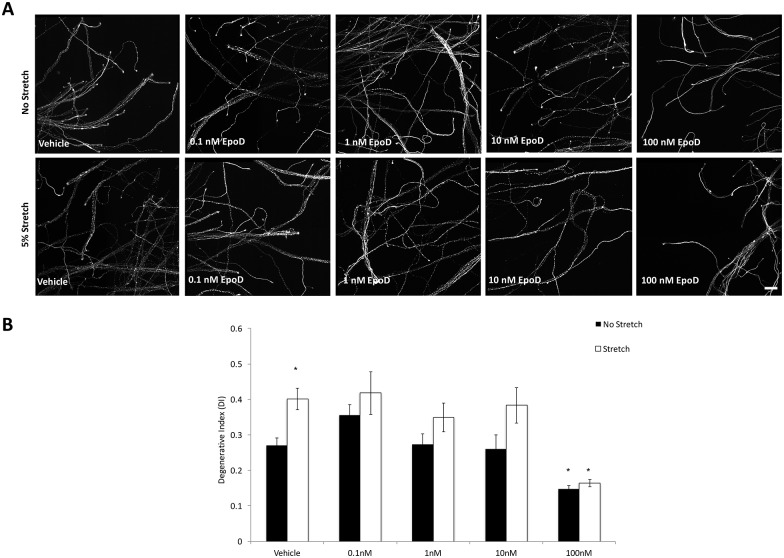
Tau (microtubule marker) immunofluorescence labeling demonstrating the effect of EpoD exposure on 5% stretched axons at 7 DIV.(A) Representative fluorescence images of unstretched and stretched culture 24 h after the indicated treatment. (B) EpoD (100 nM) applied to axon compartment alone for 24 h induced a significant decrease in degenerative index in the axon compartment when compared to vehicle- treated cultures following injury. The arterisk indicates the difference from paired control. *p<0.05. Error bar = mean ± SEM. Scale bar = 30 μm.